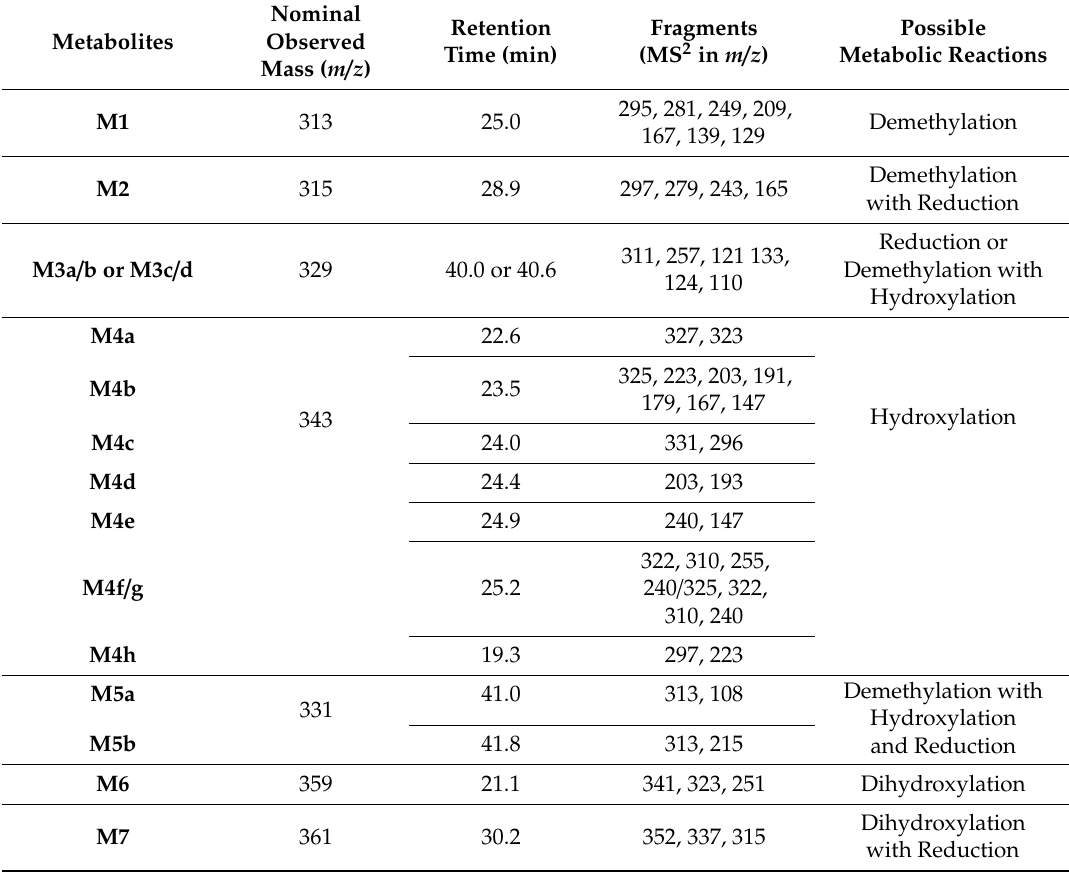
Table 2. Possible Phase-I metabolites of